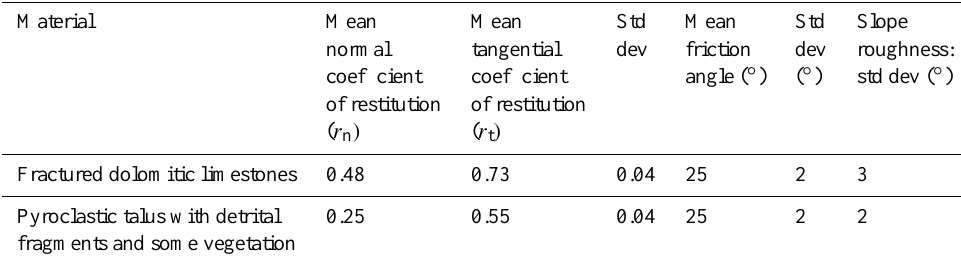
Table 2. Main geo-mechanical parameters and related standard deviations ( σ) adopted in the rockfall simulations. Material Mean Mean Std Mean normal tangential dev friction